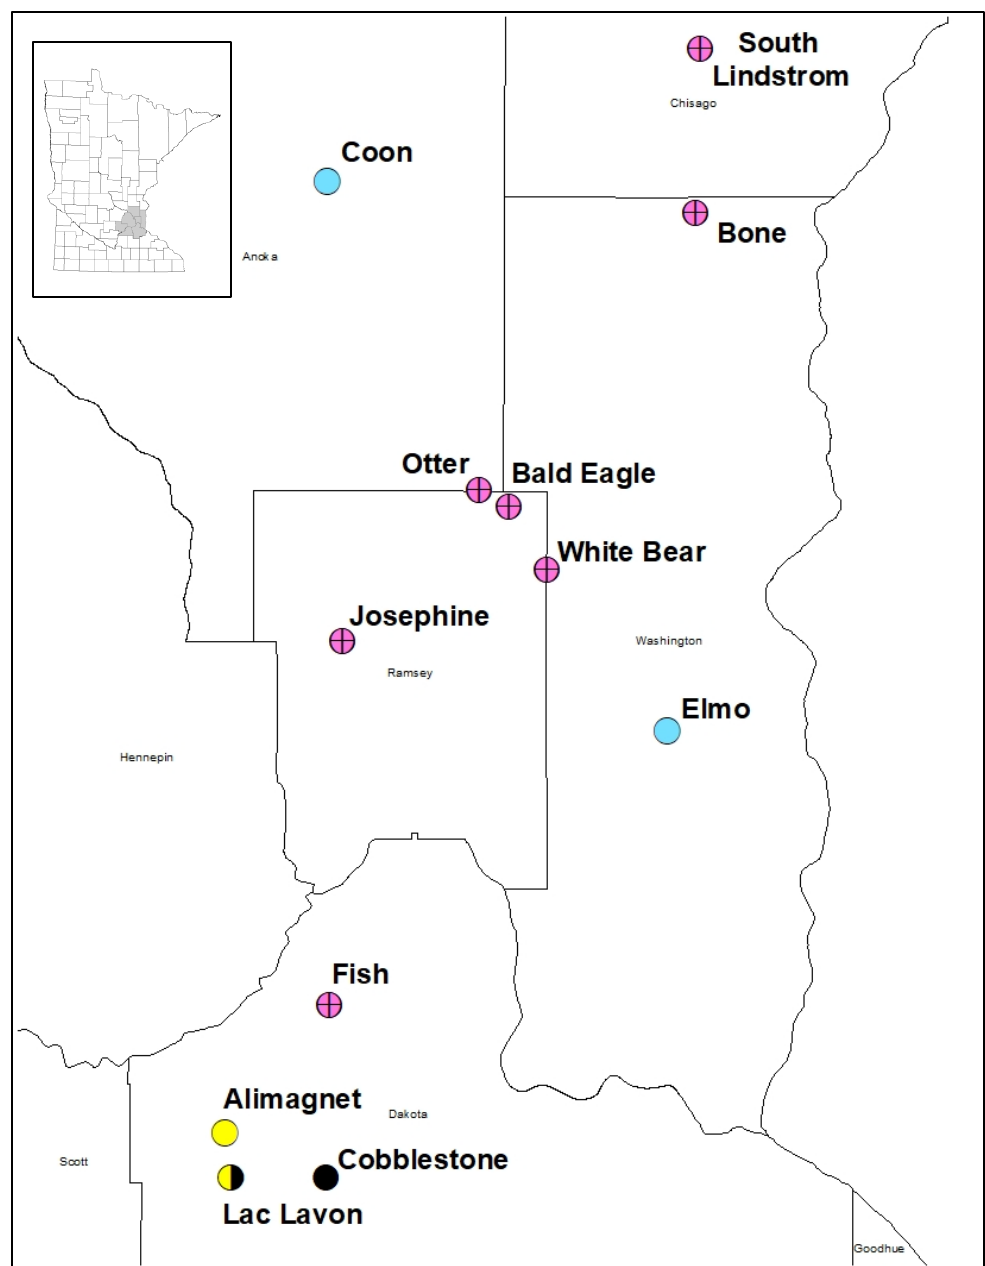
Figure 2. Distribution of shared hybrid watermilfoil genotypes in sampled lakes.